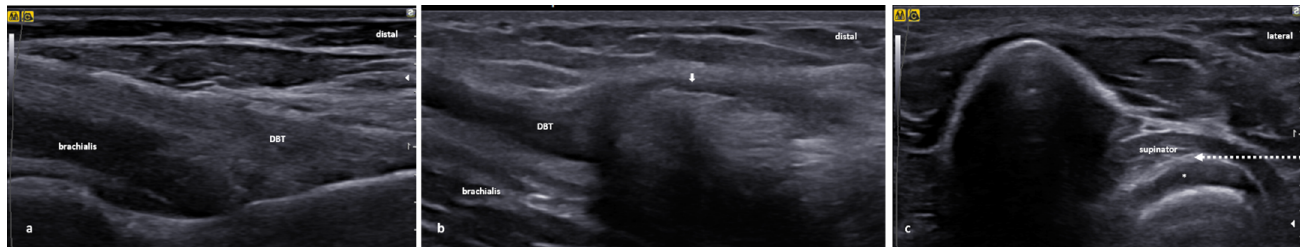
Figure 9. Ultrasound imaging and injection of distal bicep tendinopathy. ( a ) The physician sits adjacent to the examination bed while the patient is lying supine. The patient’s actively supinated forearm rests along the body. ( b ) The same position as described before in detail. ( c ) Ultrasound-guided injection of the distal bicep tendinopathy from the “cobra position”. The elbow and wrist are flexed, while the forearm is fully pronated. The probe is placed in the transverse aspect of the forearm at the radial head. The needle is inserted from lateral to medial.